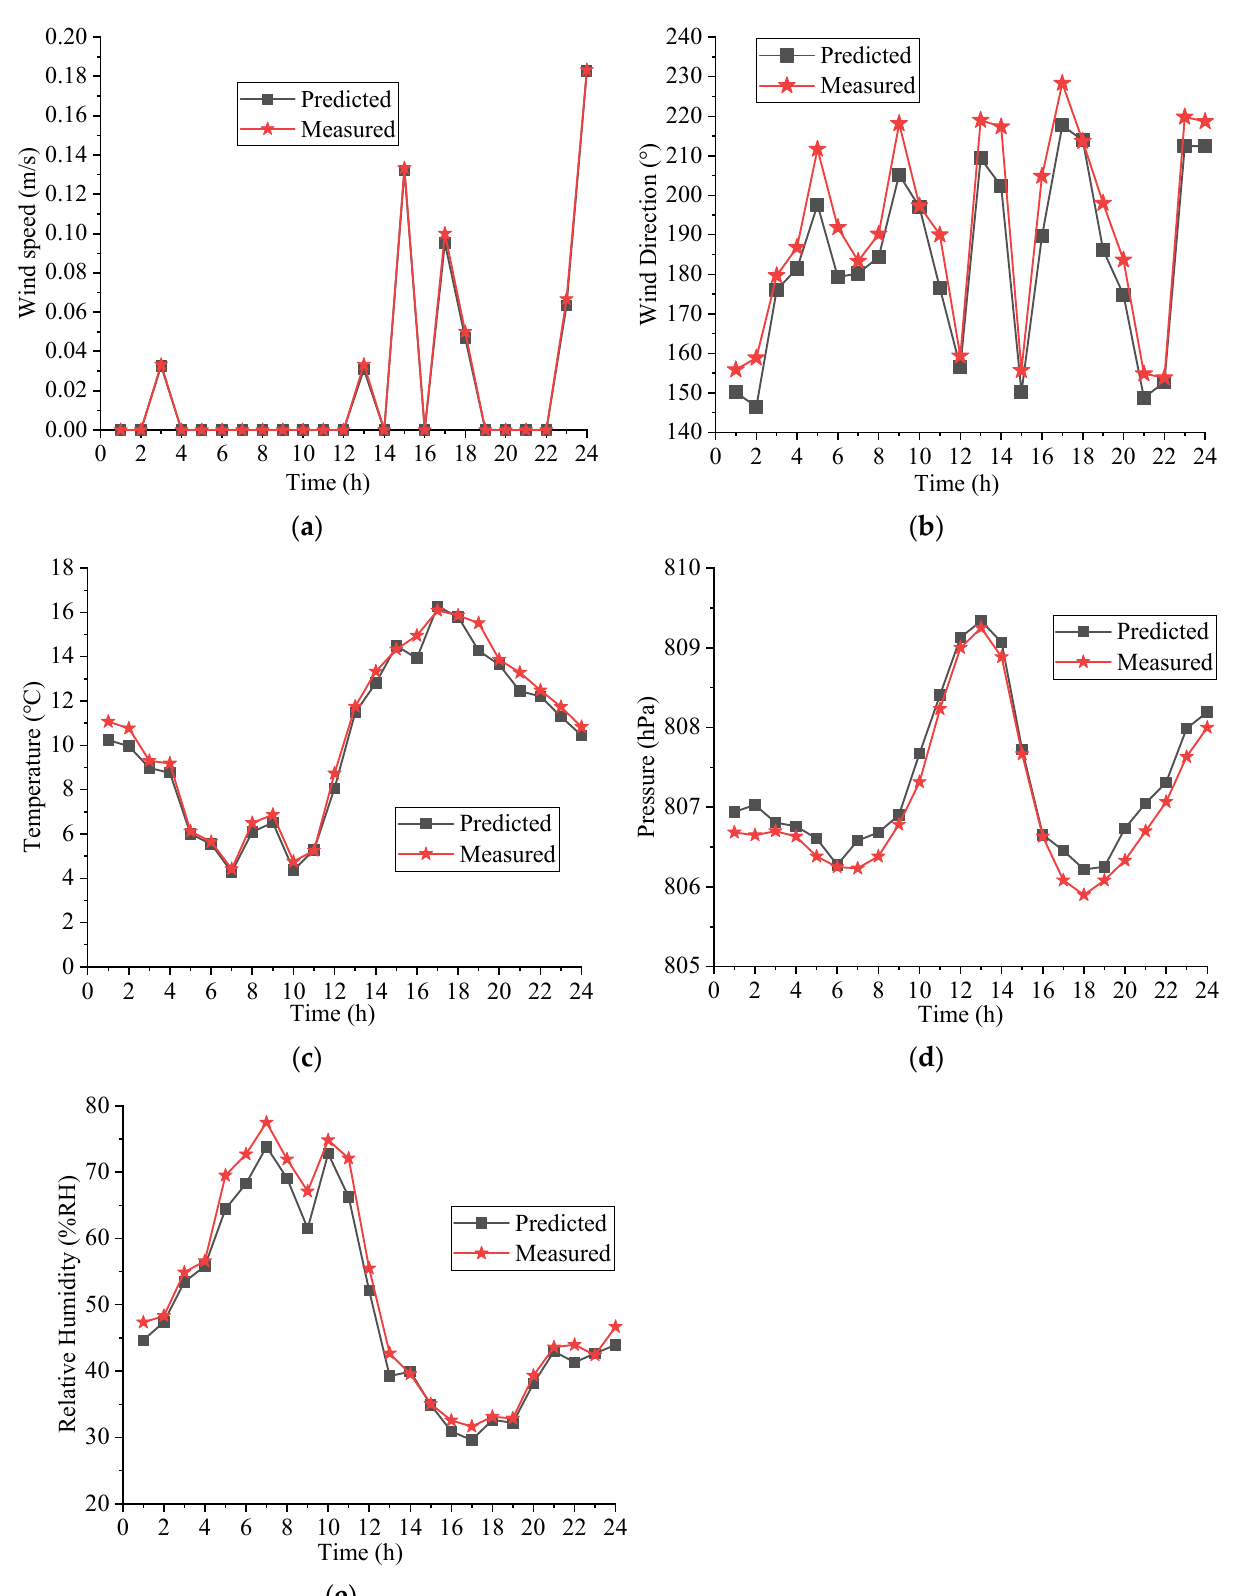
Figure 8. Curves of the predicted and measured data. ( a ) Wind speed. ( b ) Wind direction. ( c ) Temperature. ( d ) Barometric pressure. ( e ) Relative humidity.